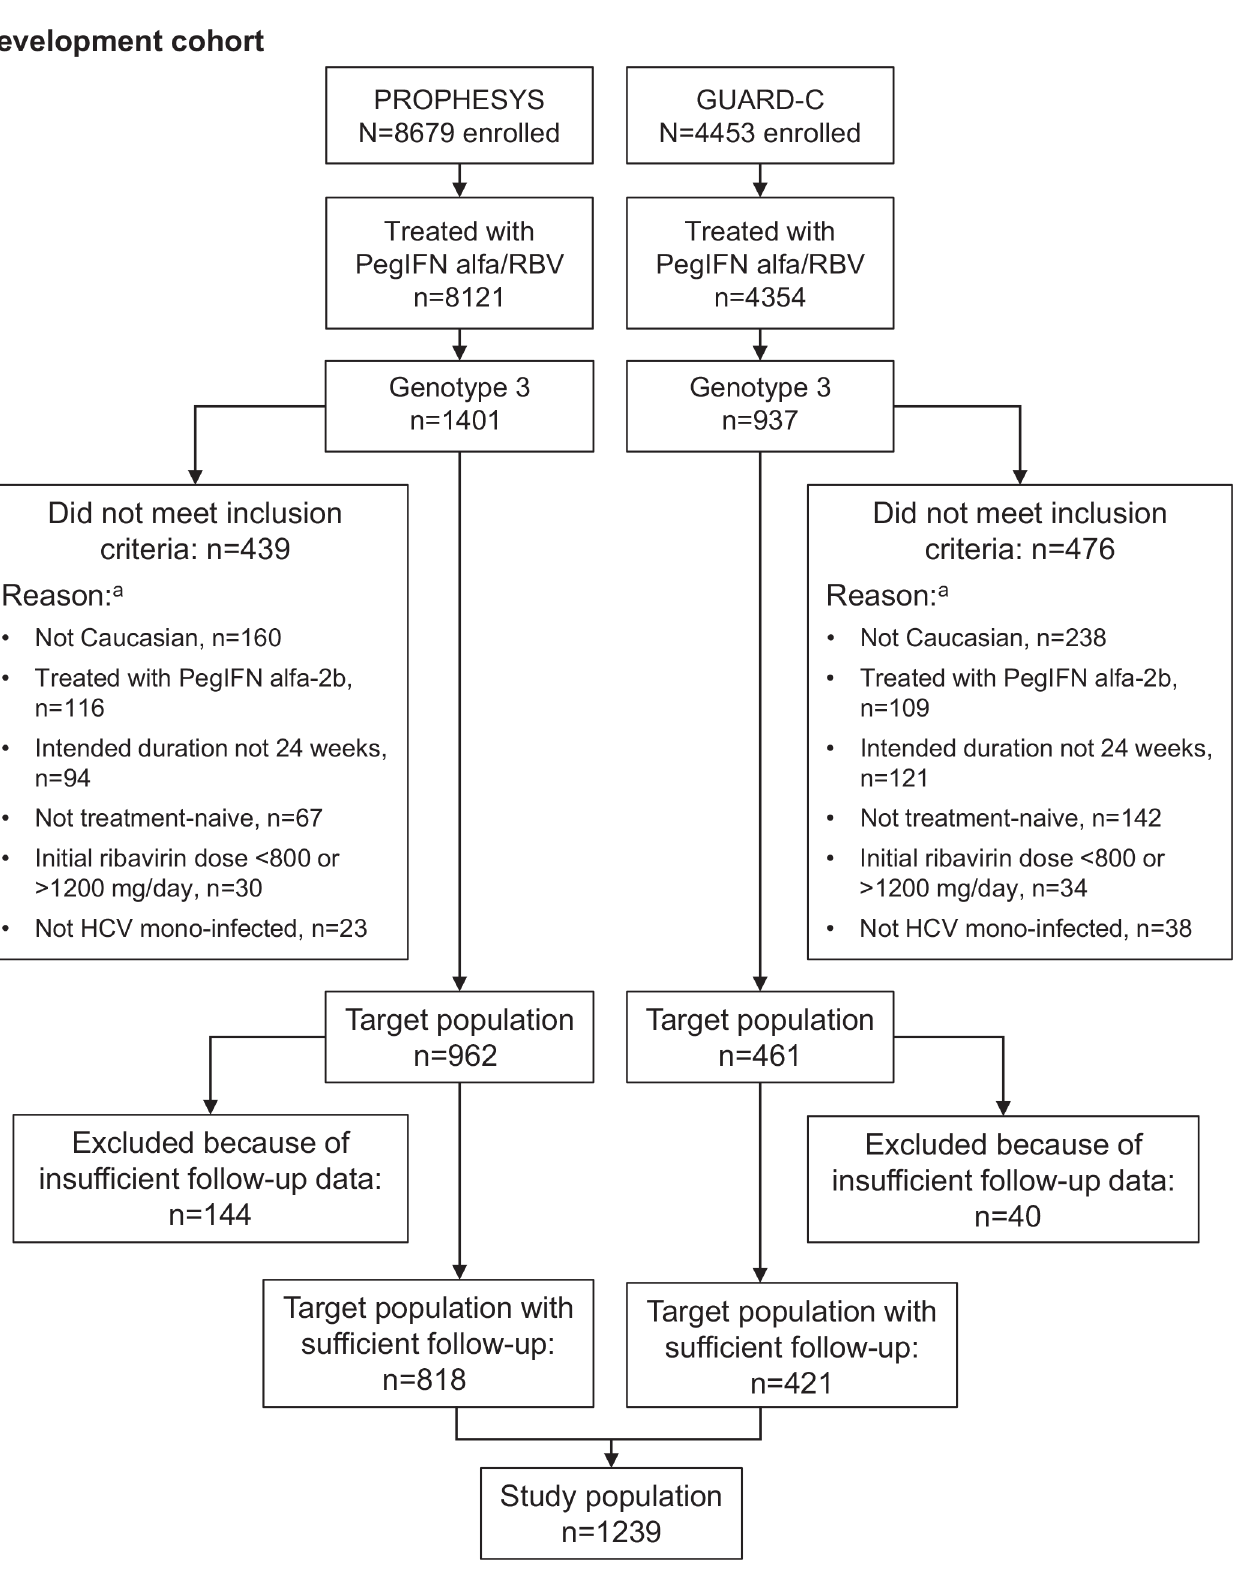
Fig 1. Patient selection for the development